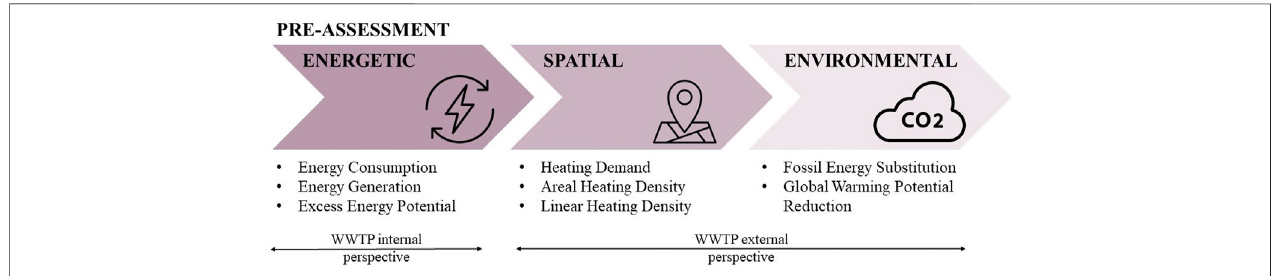
FIGURE 1 | Process Scheme for the Integrated Suitability Pre-Assessment (own illustration).